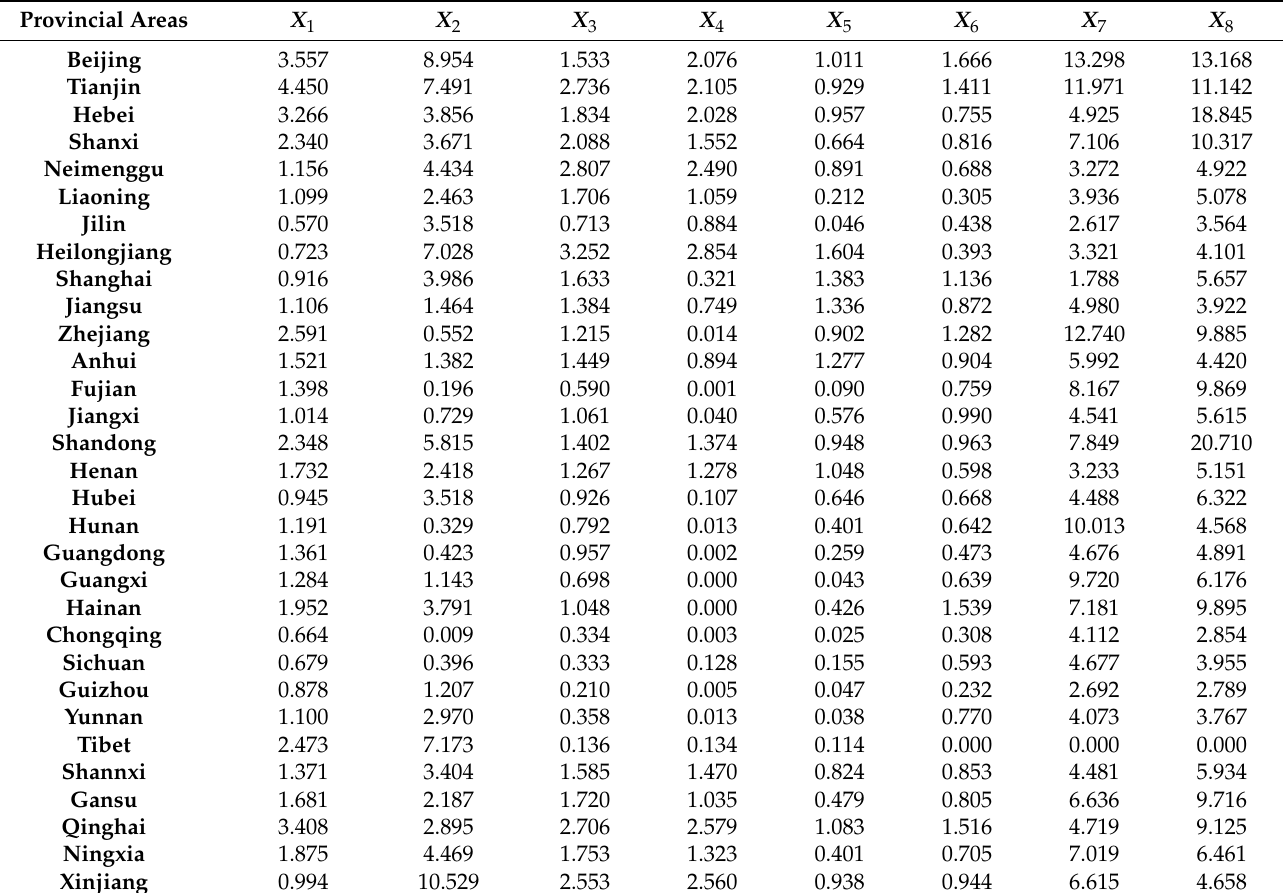
Table 1. Data of 31 provincial areas in 2005.